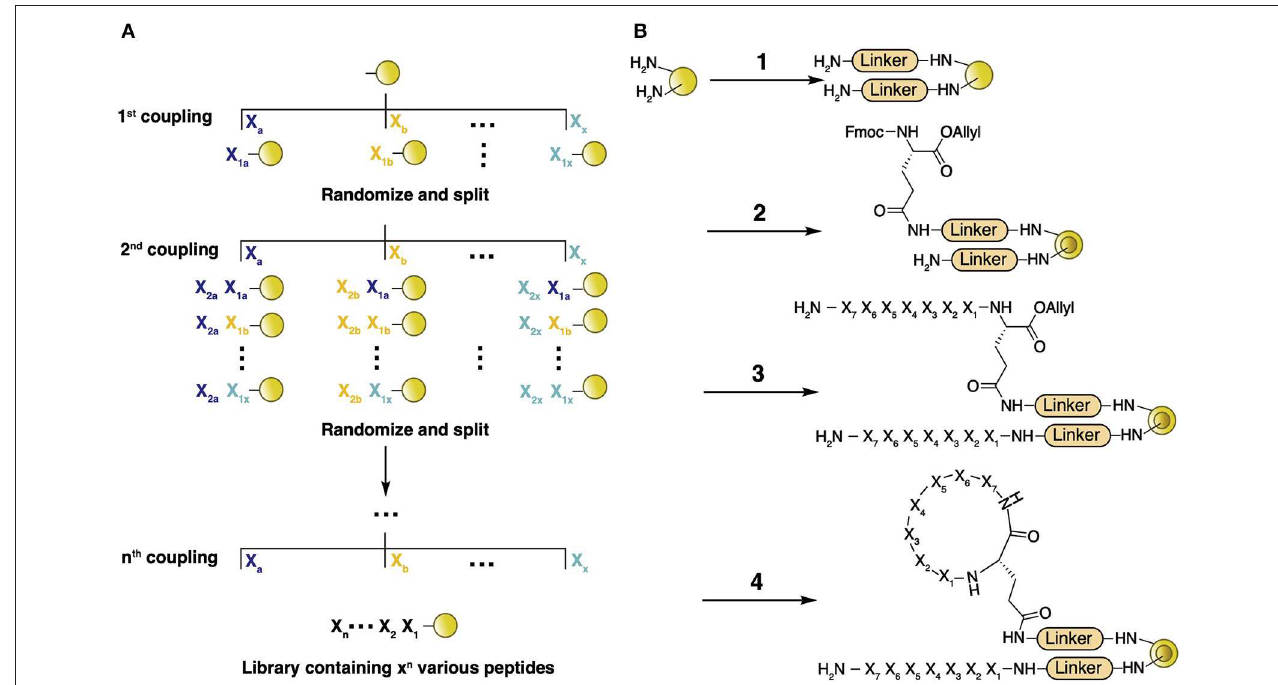
FIGURE 6 | (A) General concept of library construction by the split-and-pool method. TentaGel microbeads are prepared and split into X fractions, followed by coupling of X proteinogenic and nonproteinogenic residues onto each fraction separately. The beads are combined and mixed well, followed by splitting again into X fractions. The process of coupling, combining, and splitting is repeated for n cycles, providing a library containing a theoretical X n different molecules. (B) Backbone macrocyclic library preparation. TentaGel microbeads are prepared by the addition of a few amino acids (i.e., β -Ala and Met, etc.) as the linker (1), followed by soaking in water and addition of 0.5 equiv. of N α -Fmoc-Glu( δ -NHS)-O-CH 2 CH = CH 2 in Et 2 O/CH 2 Cl 2 (2). Peptide assembly is conducted with Fmoc SPPS (3). Deprotection of the allyl group by Ph(PPh 3 ) 4 is conducted, followed by PyBOP/HOBt head-to-tail coupling of the protected peptide